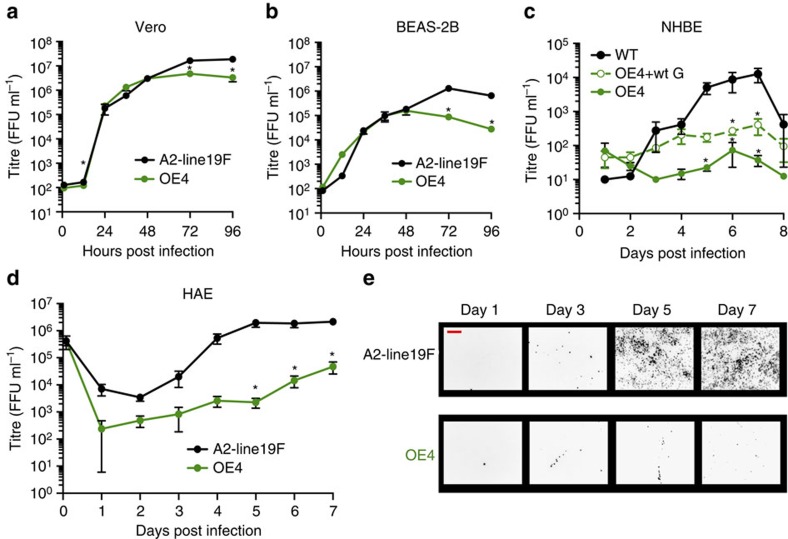
OE4 replication in immortalized and primary cell cultures.Vero (a), BEAS-2B (b), primary normal human bronchial epithelial cells differentiated at air–liquid interface (NHBE) (c), primary human tracheobronchial airway cells differentiated at air–liquid interface (HAE) (d) were infected with A2-line19F (black), OE4 (green) and in HAE, OE4+wtG (green dash) at MOI=0.01 (Vero and BEAS-2B), MOI=2.6 (NHBE), or MOI=6.7 (HAE). Samples were titrated by fluorescent focus unit (FFU) assays on Vero cells. (e) Representative images of infected HAE cultures. Scale bar represents 200 μm. Graphs depict the means±s.e.s of the means combined from three experiments (Vero and BEAS-2B), from two donors in duplicate (NHBE), or from six cultures from a single donor per virus (HAE). When significant, P values are shown relative to A2-line19F (*P<0.05; by two-way ANOVA).